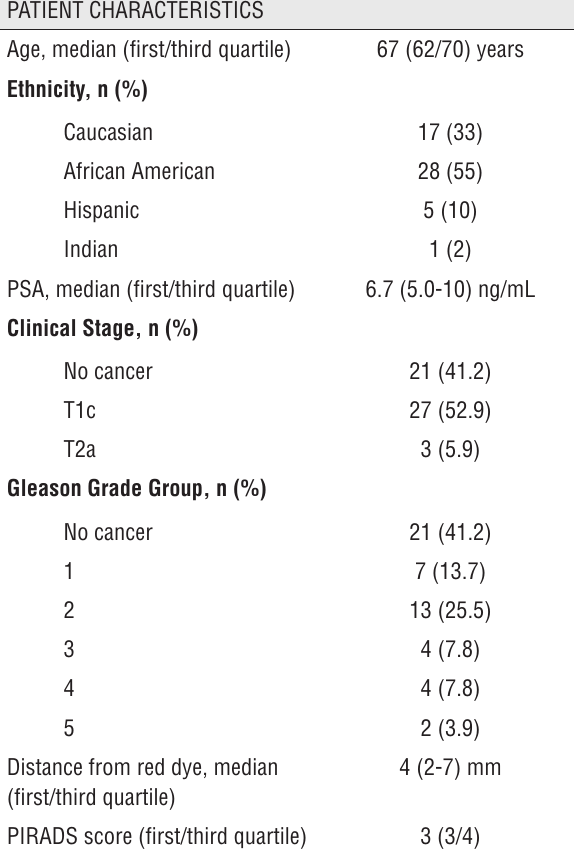
Table 1 - Details of Cohort.